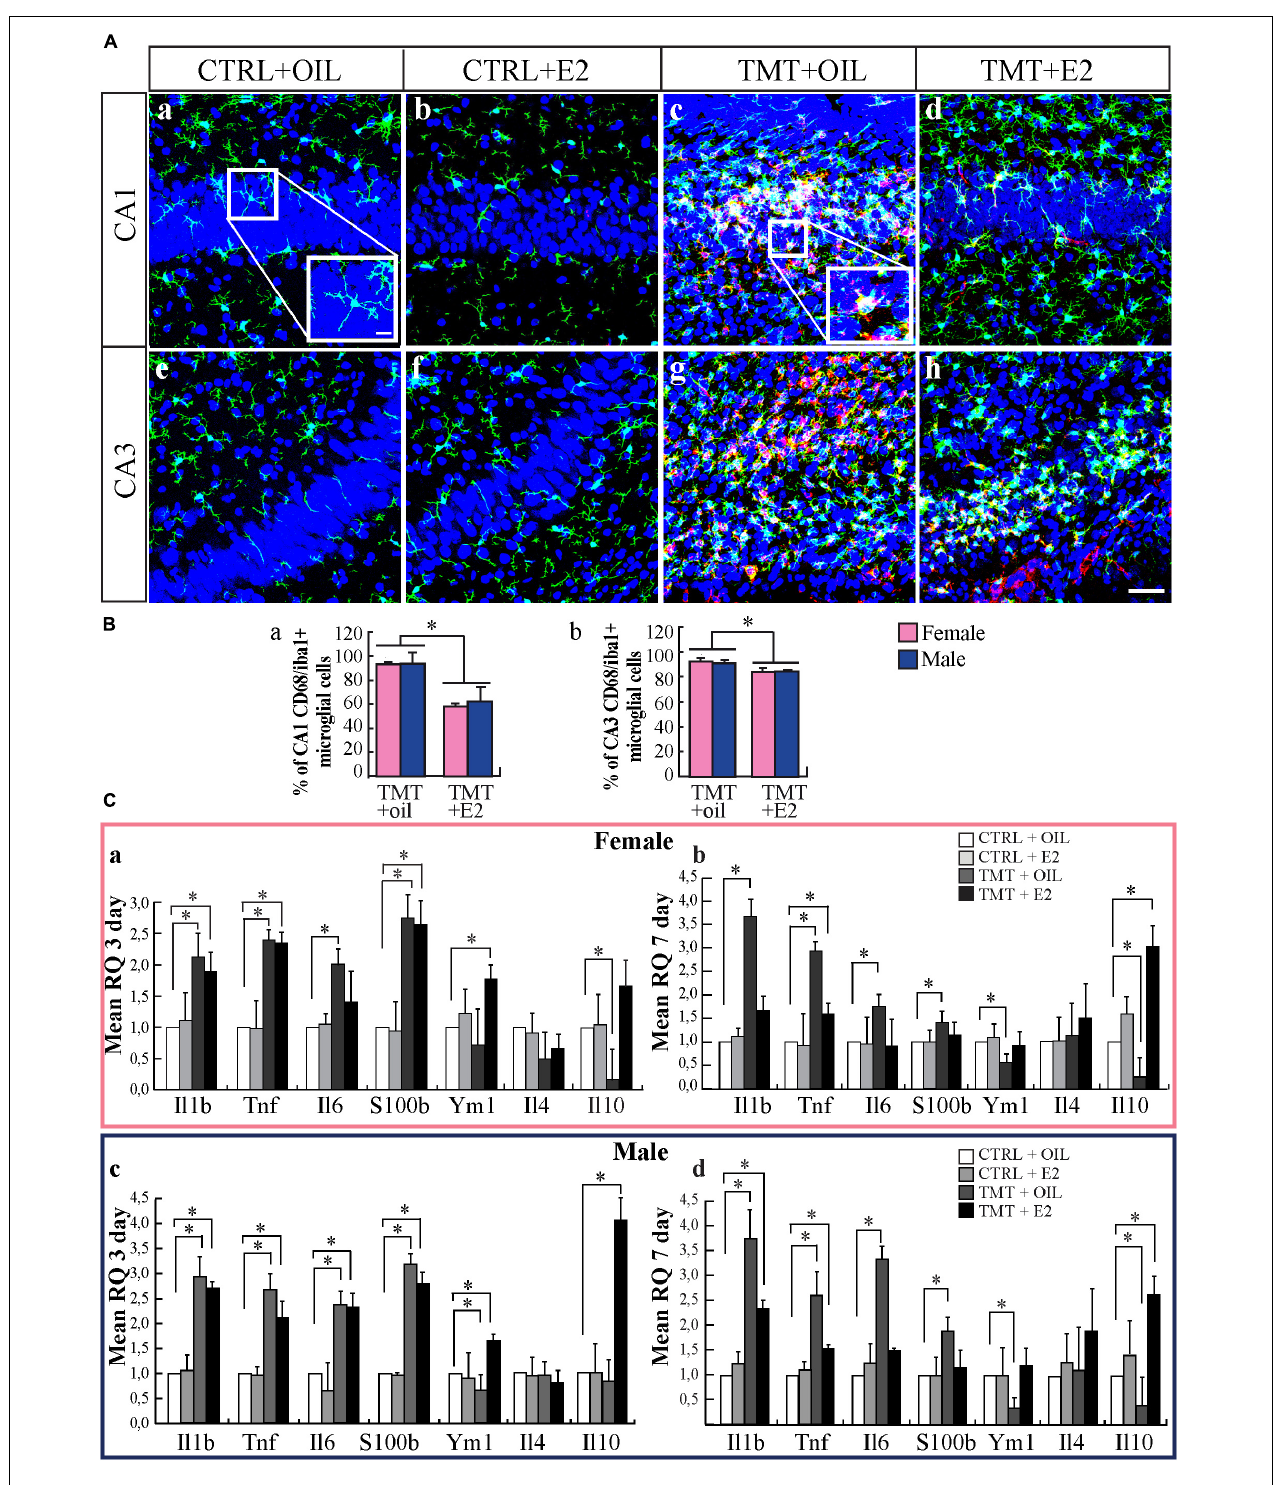
FIGURE 2 | 17 β -estradiol (E2) reduces microglial activation during trimethyltin (TMT)-induced hippocampal damage. (A) Representative confocal microscopy micrographs of CA1 (a–d) and CA3 (e–h) hippocampal subfields from CTRL+oil- (a,e) , CTRL+E2- (b,f) , TMT+oil- (c,g) , and TMT+E2- (d,h) treated animals double-labeled for Iba1 ( green ), CD68 ( red ) and counterstained with the nuclear dye TO-PRO ( blue ). Larger Iba1-immunoreactive cell bodies, exhibiting thicker and shortened processes are evident in the hippocampi of TMT-treated animals (enlarged image included in the box in c ) compared with CTRL (enlarged image included in the box in a ). In addition, a reduced expression of activated microglia double-stained for Iba1/CD68 is evident in the TMT+E2-treated group (d,h) . Scale bar: 60 µ m (a–h) . Scale bar: 10 µ m (boxes in a and c ). (B) Bar graphs indicating the percentage of Iba1/CD68 double-stained cells in CA1 and CA3 pyramidal layers